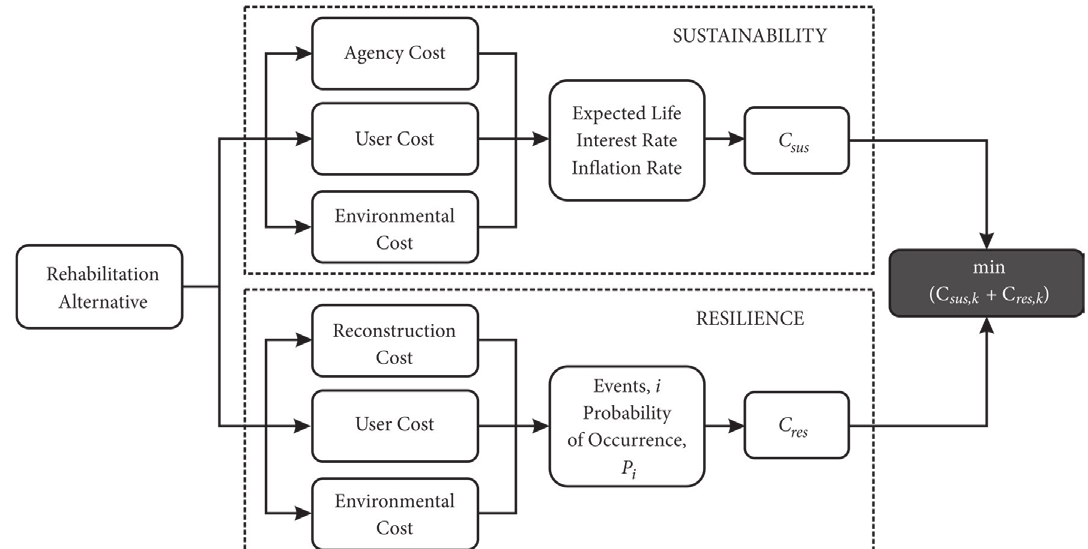
Fig. 4 . Diagram of the proposed integrated